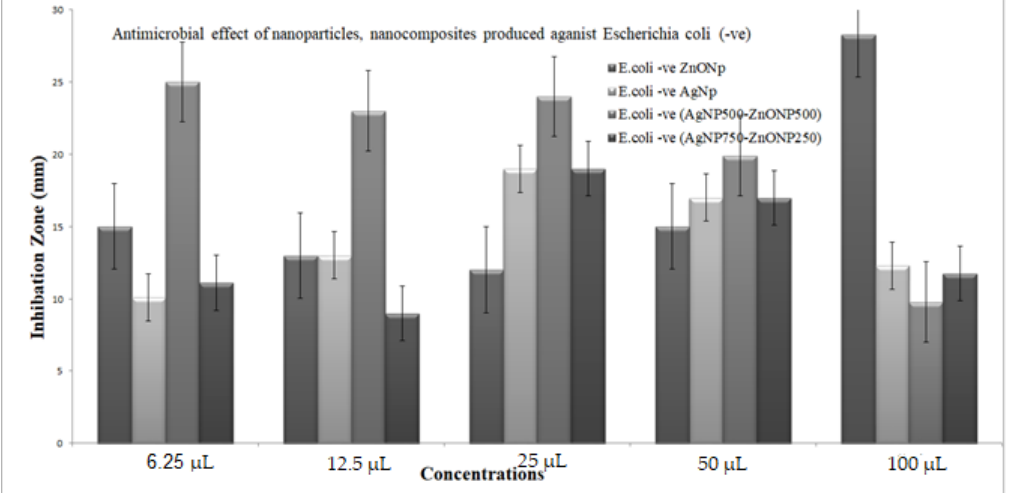
Figure 9. The antimicrobial activity of the nanoparticles and nanocomposite produced against Escherichia coli . Data showing increasing inhibition zone with increasing amounts of nanoparticles: 6.25, 12.5, 25, 50 and 100 µ L with volume made up to 100µLwith distilled water wherever needed. Zinc oxide nanoparticles (ZnONPs); silver nanoparticles (AgNPs); composite 500 µL AgNPs–500 µL ZnONPs; composite 750 µL AgNPs–250 µL ZnONPs nanoparticles. SD±, standard deviation.